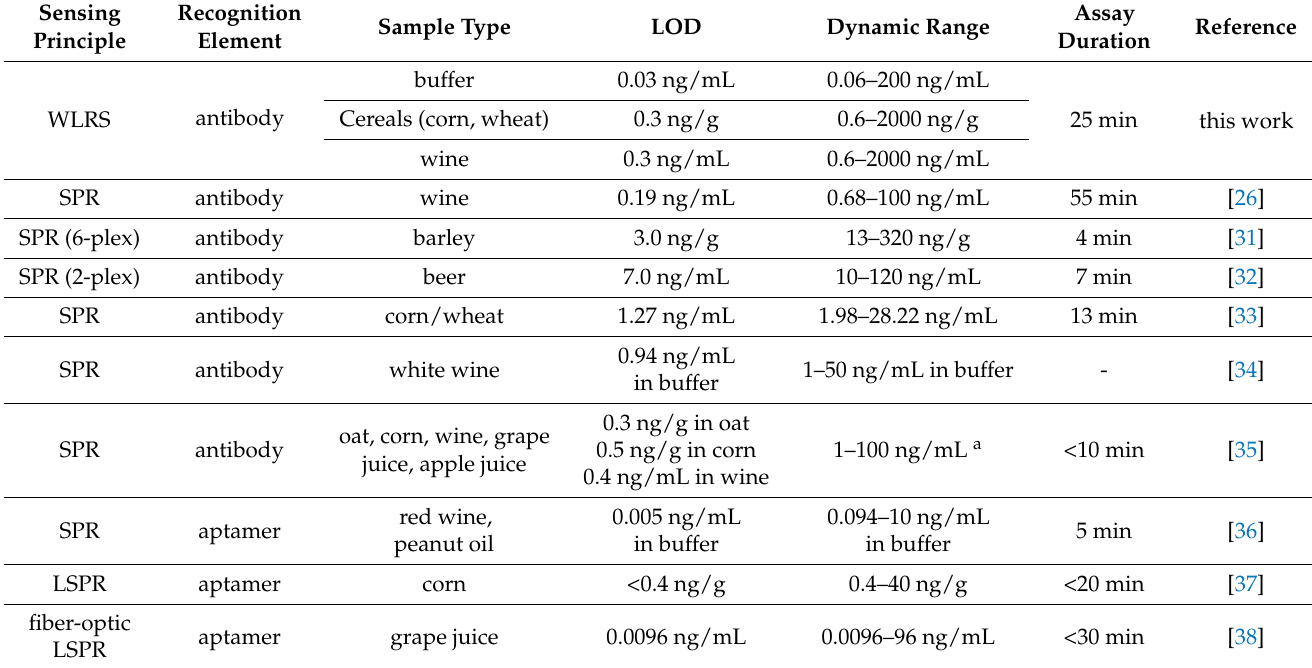
Table 4. Comparison of the WLRS-immunosensor developed for OTA determination with other OTA label-free optical sensors reported in the